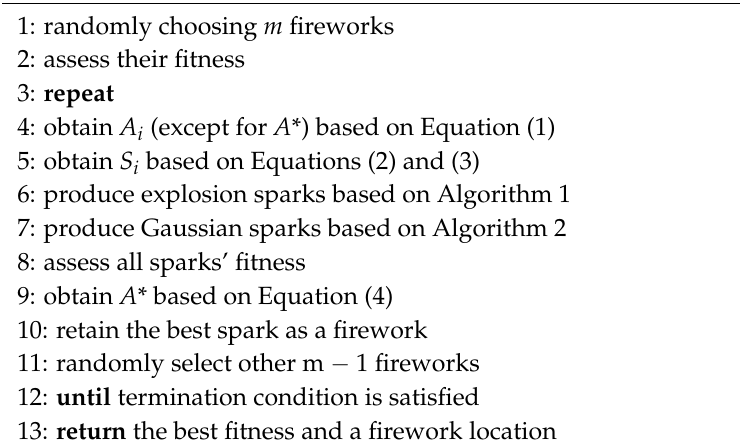
Algorithm 3 Pseudo-Code of AFWA